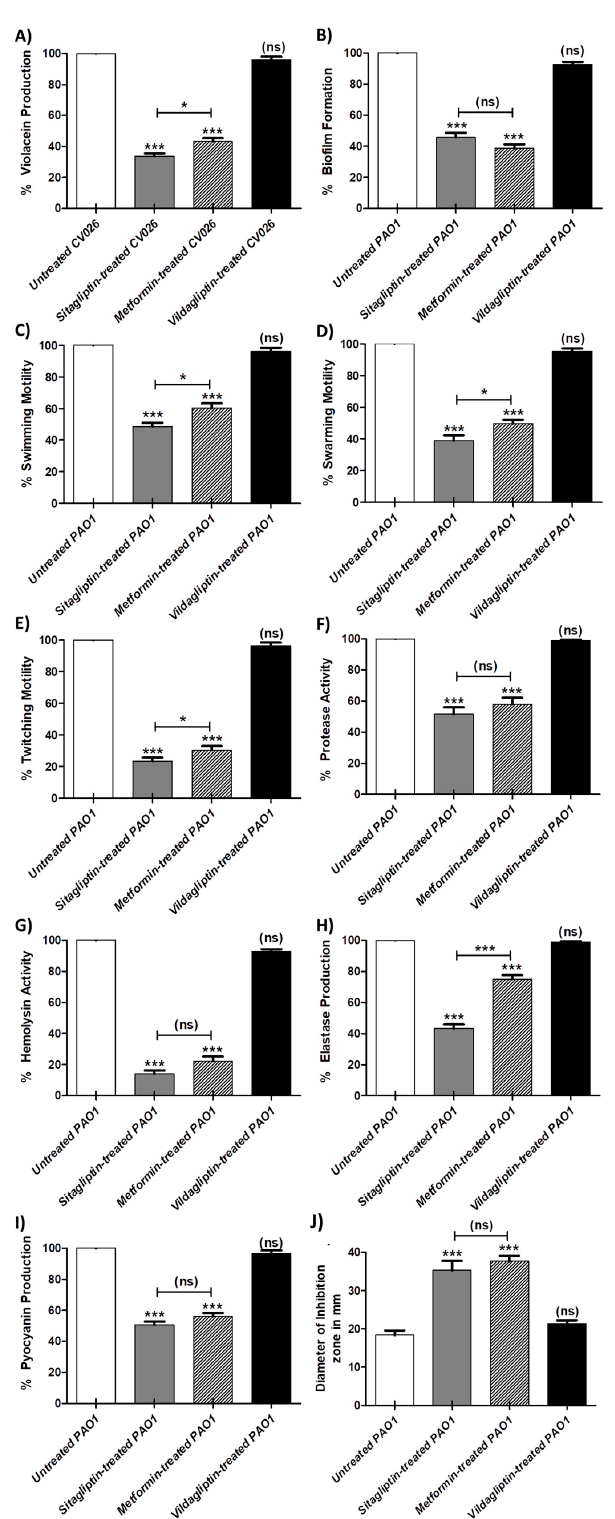
Figure 2. Inhibitory effect of the tested anti-diabetic drugs on bacterial virulence. Bacterial cultures were prepared with and without 1/10 MIC of sitagliptin, metformin or vildagliptin. The one-way